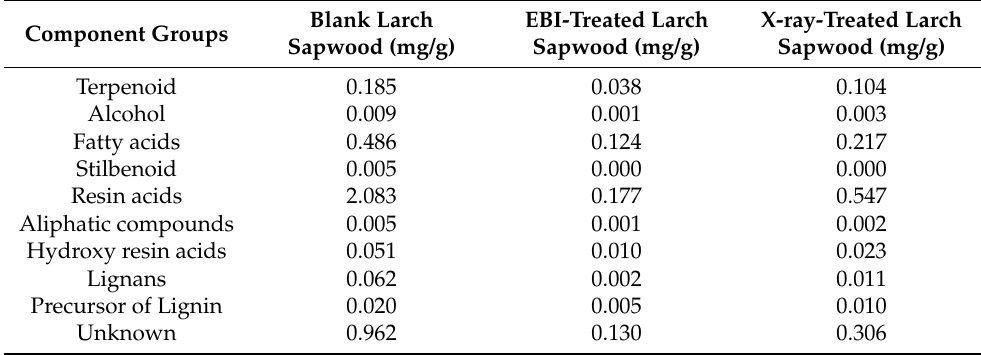
Table 1. Main component groups in hexane extracts of different treated larch sapwood samples by gas chromatography–mass spectrometry